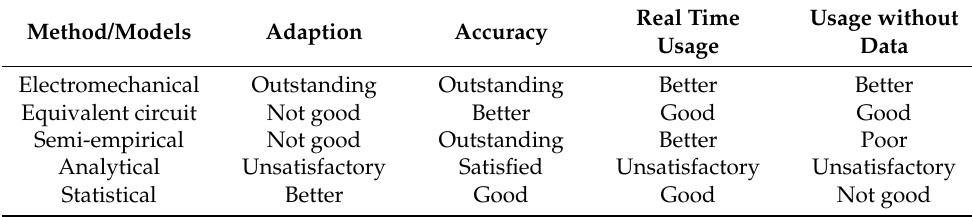
Table 2. Comparison of different approaches for SOH assessment